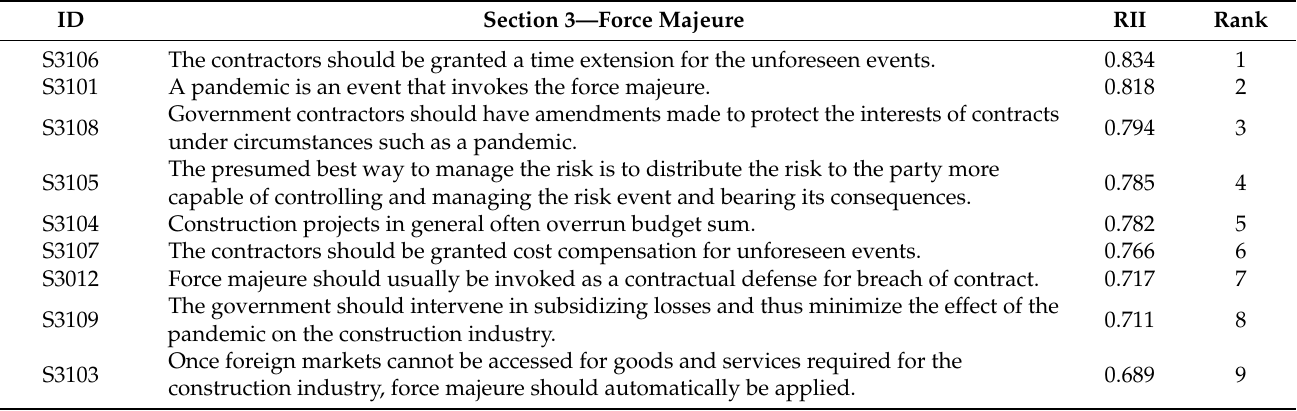
Table 6. The relative importance index and its ranking for Section 3 questions as it relates to force majeure in the construction industry.